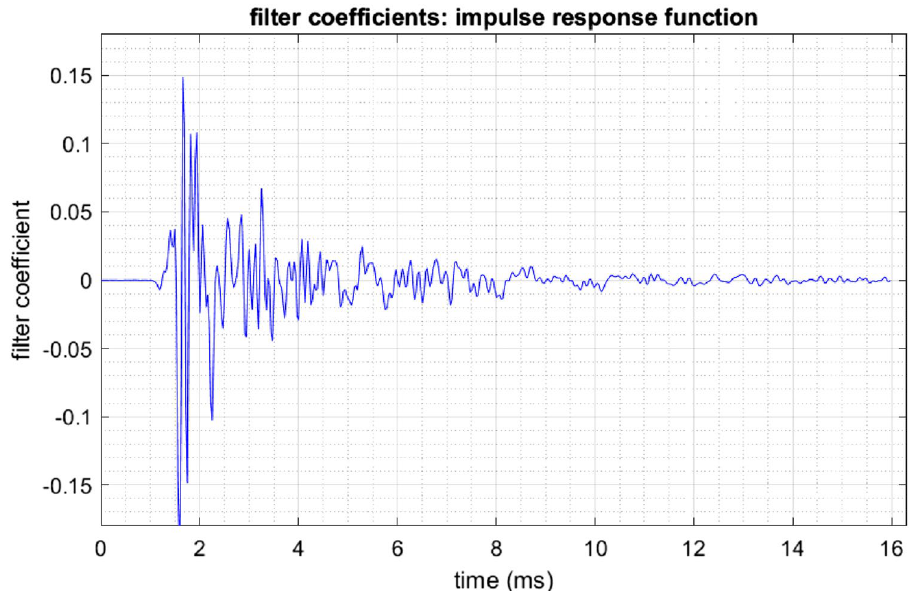
Figure 10. The impulse response (IR) function of the isolation chamber containing a plexiglass cage (between the loudspeaker and the microphone). The distance between the microphone and loudspeaker was about 50 cm, in agreement with the ~ 1.5 ms lag of the first IR